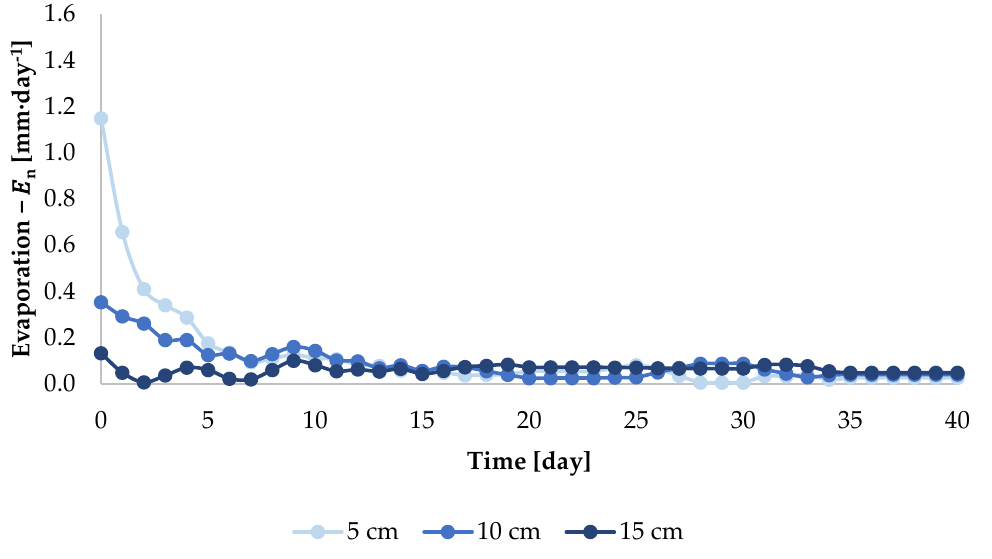
5 cm, the value of was 0.29 mm· day − 1 , for 10 cm was 0.19 mm· day − 1 , and for the depth 𝐸𝐸 𝑛𝑛 of 15 cm, the value of was 0.07 mm· day − 1 . The above ana lyses indicate that evapora- 𝐸𝐸 𝑛𝑛 tion intensity for injection irrigation increases with increasing doses and decreases with 𝐸𝐸 𝑛𝑛 increasing depth of injection. This fact indicates the correctness of the experiment and of Figure 5. Diurnal evaporation intensity, E n , after the injection of 250, 450, 750 and 1000 cm 3 of water at the depth of 10 cm. the calculations. , after the injection of 250, 450, 750 and 1000 cm 3 of water at the depth of 10 cm. Figure 5. Diurnal evaporation intensity,